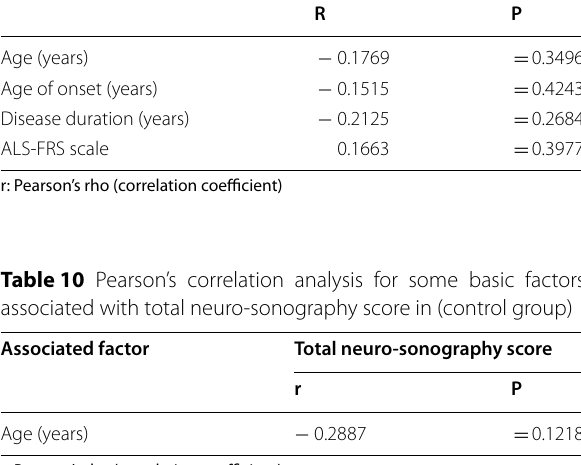
Table 9 Pearson’s correlation analysis for some basic factors associated with total neuro‑sonography score in (ALS group) Associated factor